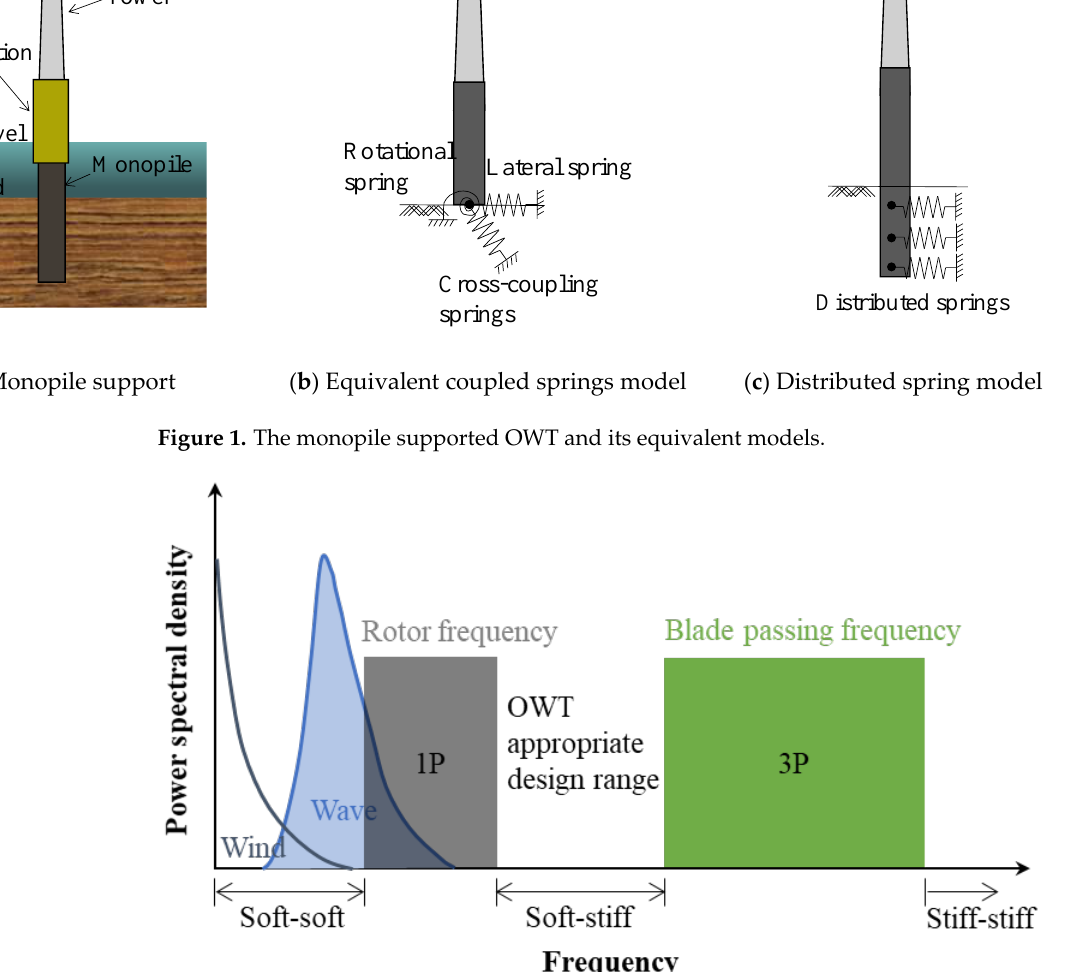
Figure 1. The monopile supported OWT and its equivalent models.